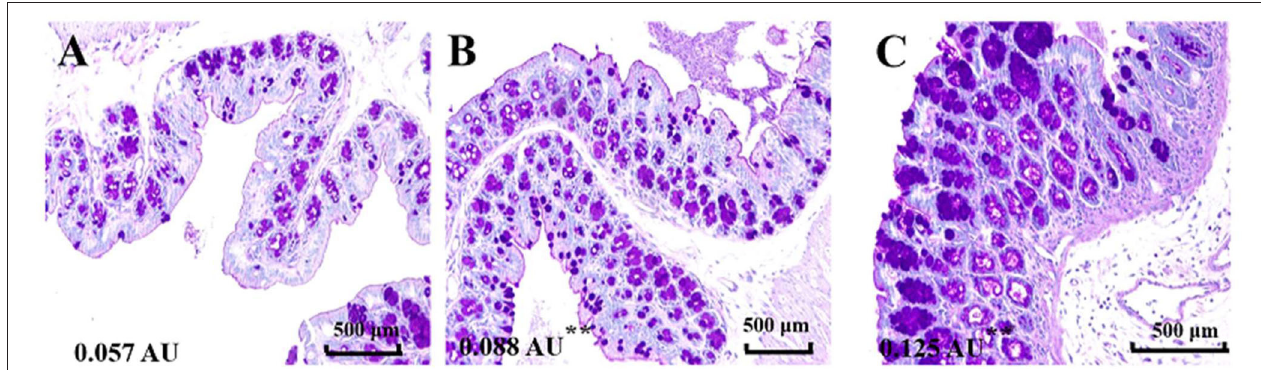
FIGURE 1 | Cinnamaldehyde treatment promoted the production of mucins. The variation of goblet cells in different treatment groups was analyzed by AB/PAS staining (200 × , n = 3). (A) Control. (B) CIN100. (C) CIN200. The mean fluorescence intensity of each picture is 0.057, 0.088**, 0.125** arbitrary units (AU) using ImageJ software. One-way ANOVA was carried out for each comparison with HSD test.